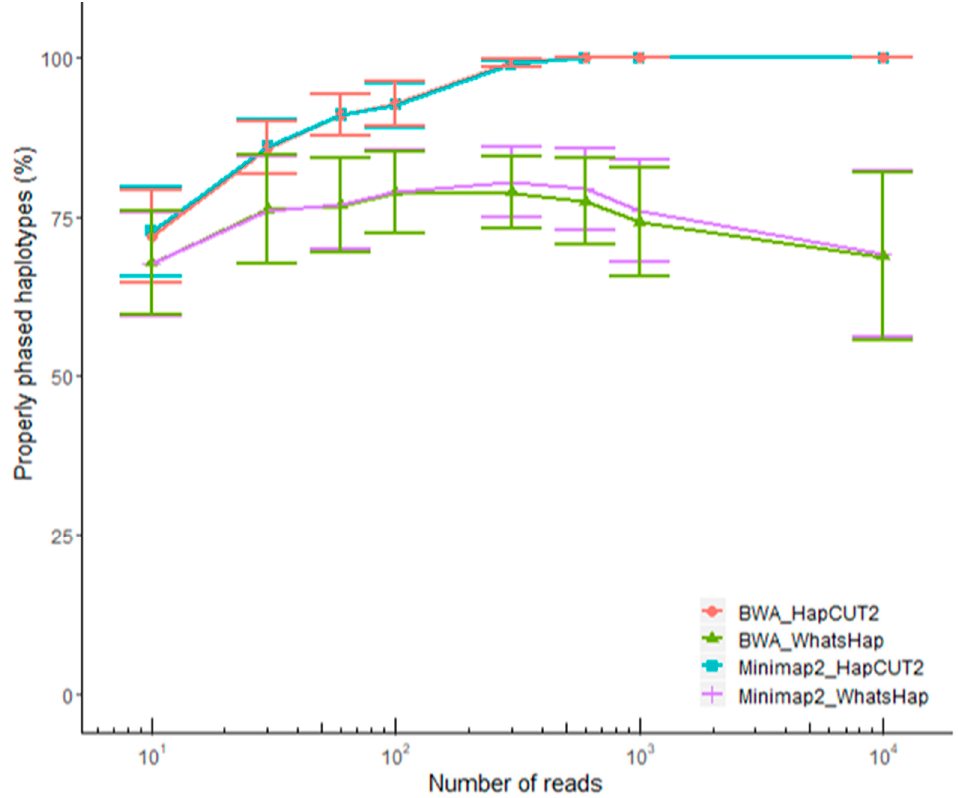
Figure 6. Accuracy of full haplotype reconstruction. Haplotypes were called 100 times using all possible combinations of two alignment and phasing software and different read numbers (10, 30, 60, 100, 300, 600, 1000, and 10,000). The graph shows the frequency at which the fully correct haplotype was called (averaged across samples) with error bars representing the standard error.